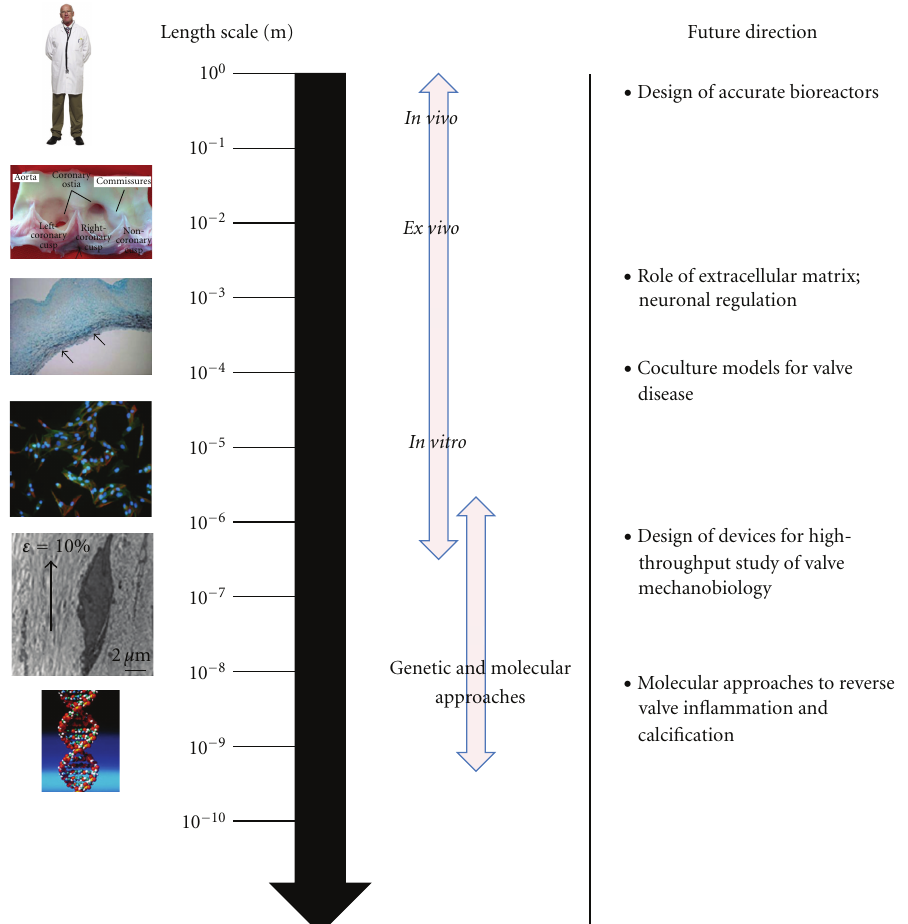
Figure 7: Multiscale, hierarchical approach that is recommended for approaching the study of valve mechanobiology and mechanopathol-